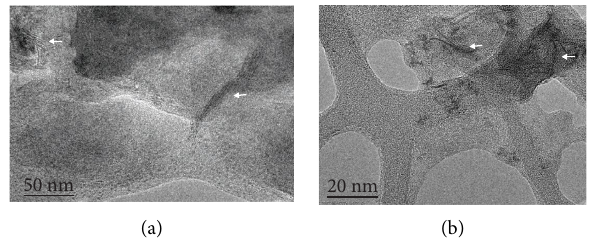
Figure 9: (a) Transmission electron microscope image of NCs obtained by enzymatic hydrolysis. Nanoparticles typically have a straight rod morphology and form aggregates. Arrows point to nanocellulose groups. Line size (50nm). Author himself. (b) Transmission electron microscope image of NCs obtained by acid hydrolysis. Nanoparticles typically have a straight rod morphology and form aggregates. Arrows point to nanocellulose groups. Line size (20nm). Author